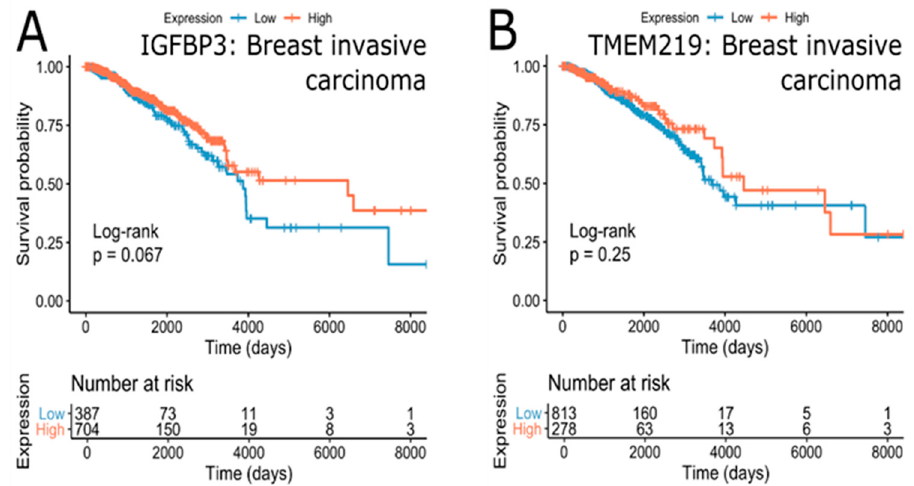
Figure 8. Kaplan-Meier plots of breast cancer cohort with survival outcomes separated by the expression of IGFBP-3 ( A ) and TMEM219 ( B ). Unadjusted p -values are